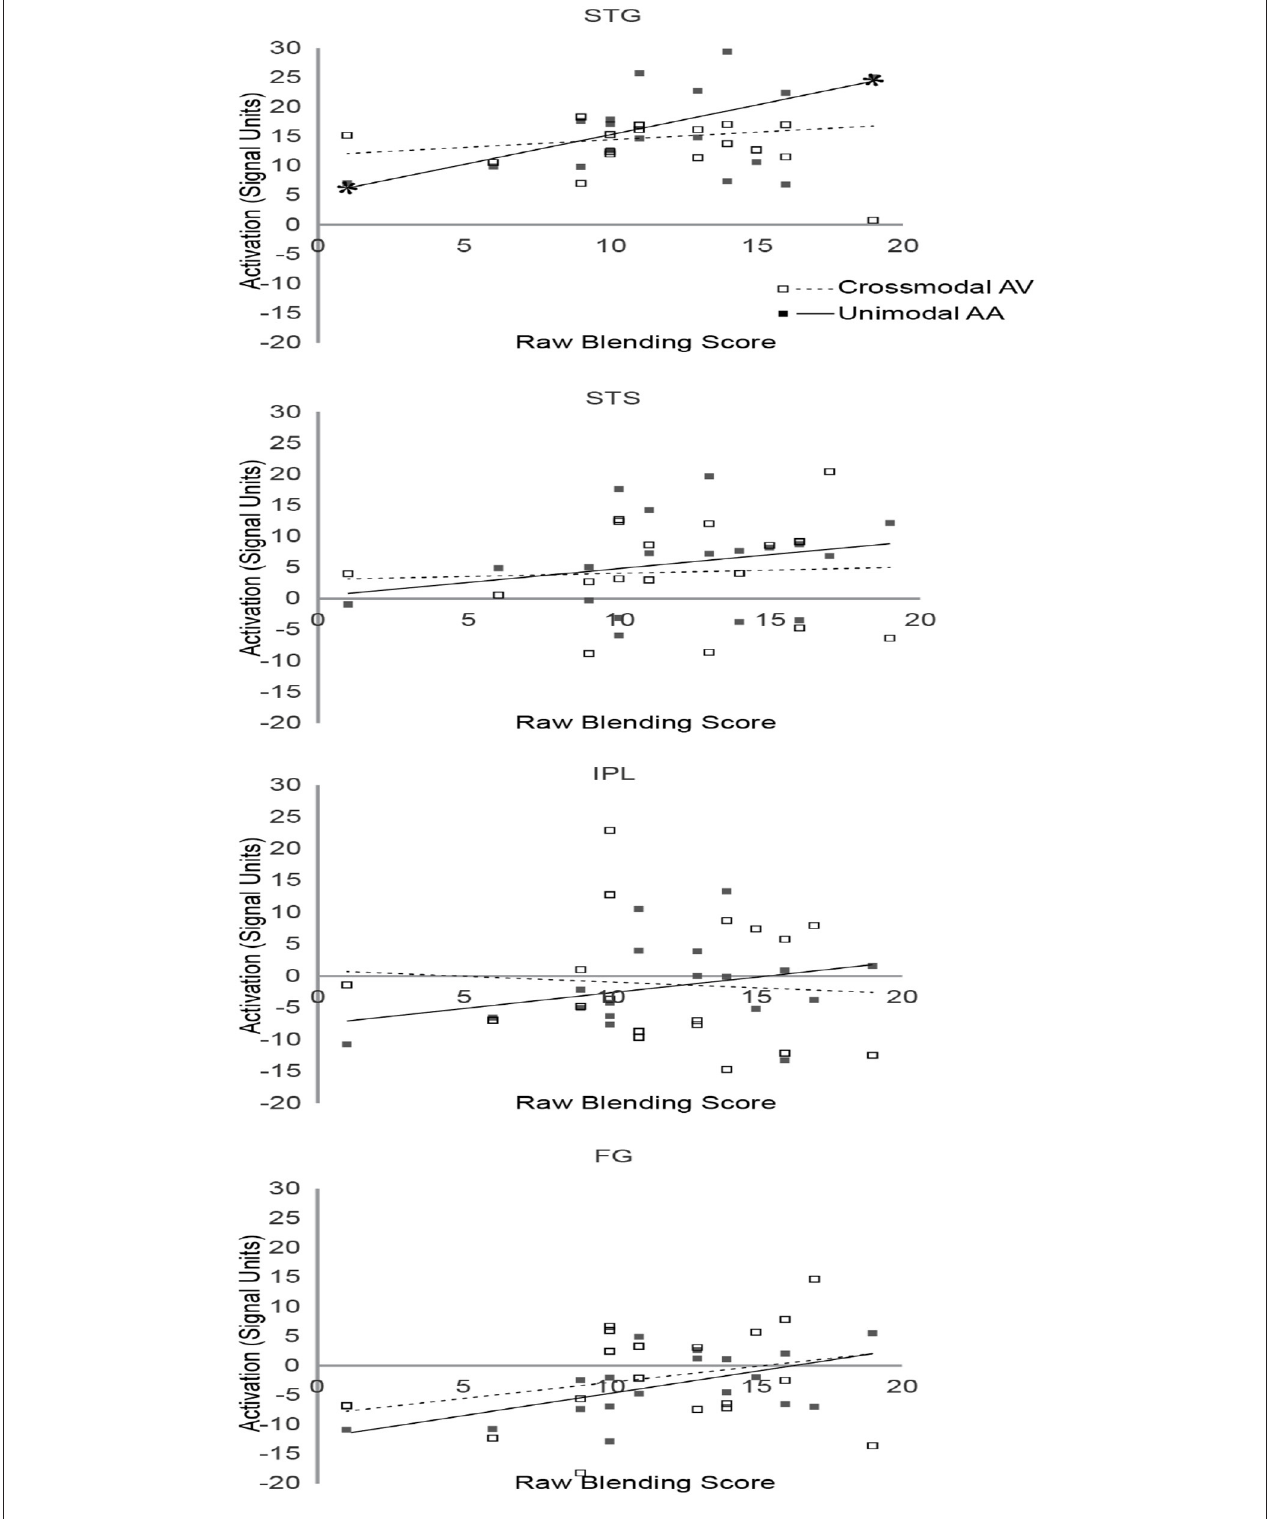
FIGURE 5 | Scatterplot diagram of ROI activations as a function of Blending scores. Significant regression lines are capped with asterisks.